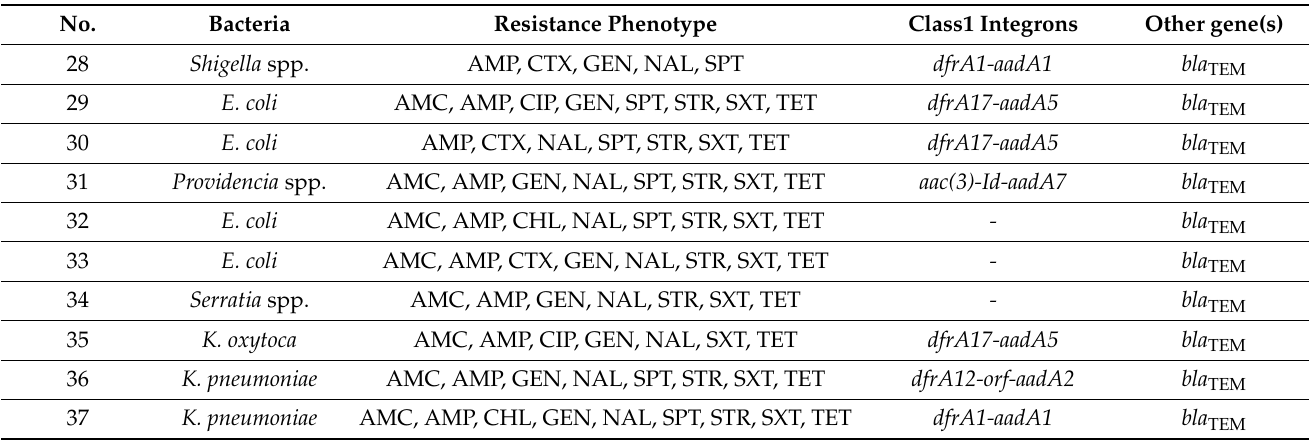
Figure 2. Electrophoresis pattern on agarose gel (1.0%) made by the amplicons for the bla TEM genes (1080 bp). Lane M is a 100 bp ladder as a molecular size standard. Lanes 2, 6–7, 11, 13, and 14: positive isolates. Lanes 1, 3–5, 8–10, 12: negative isolates.